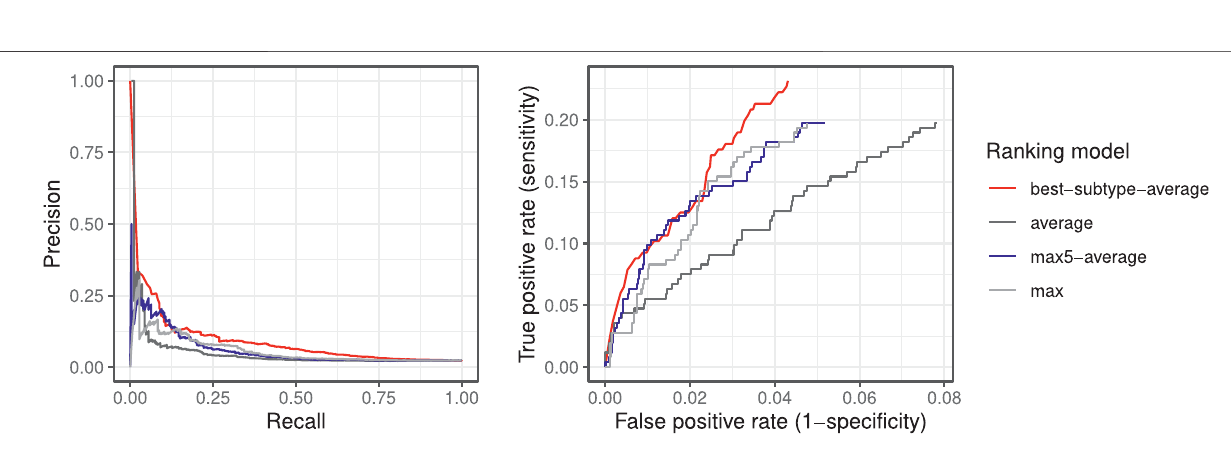
Frontiers in Pharmacology |